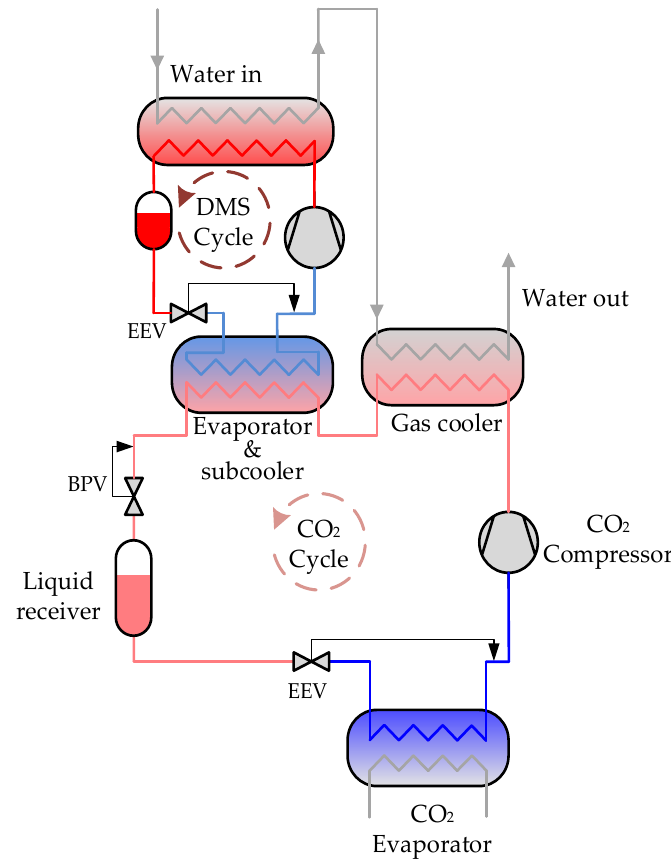
Figure 2. DMS cycle combined with a transcritical CO 2 heat pump without IHX.